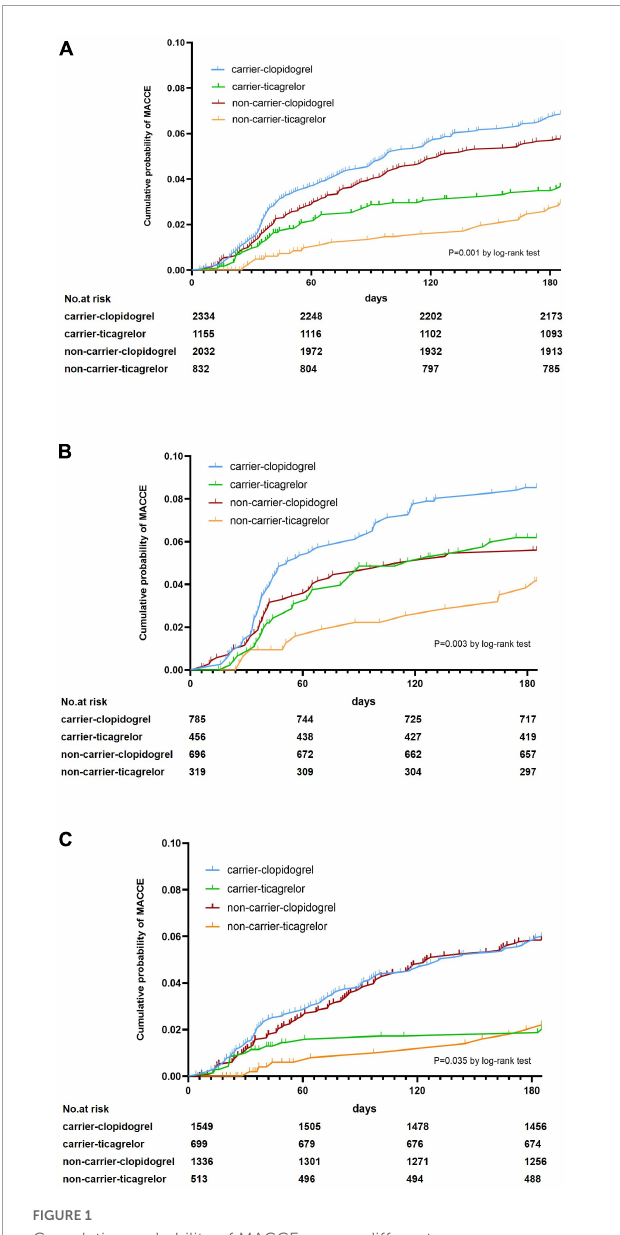
FIGURE1 Cumulative probability of MACCE among different